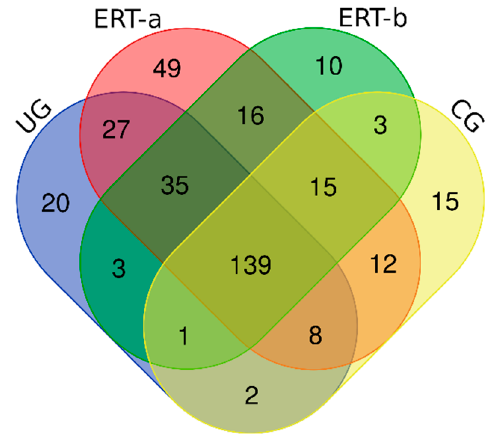
Figure 1. Venn diagram showing the distribution of proteins in the 4 study groups. Abbreviations: CG: control group; ERT-a, patients sampled before enzyme infusion; ERT-b, patients sampled 24 h after enzyme infusion; UG: untreated group.